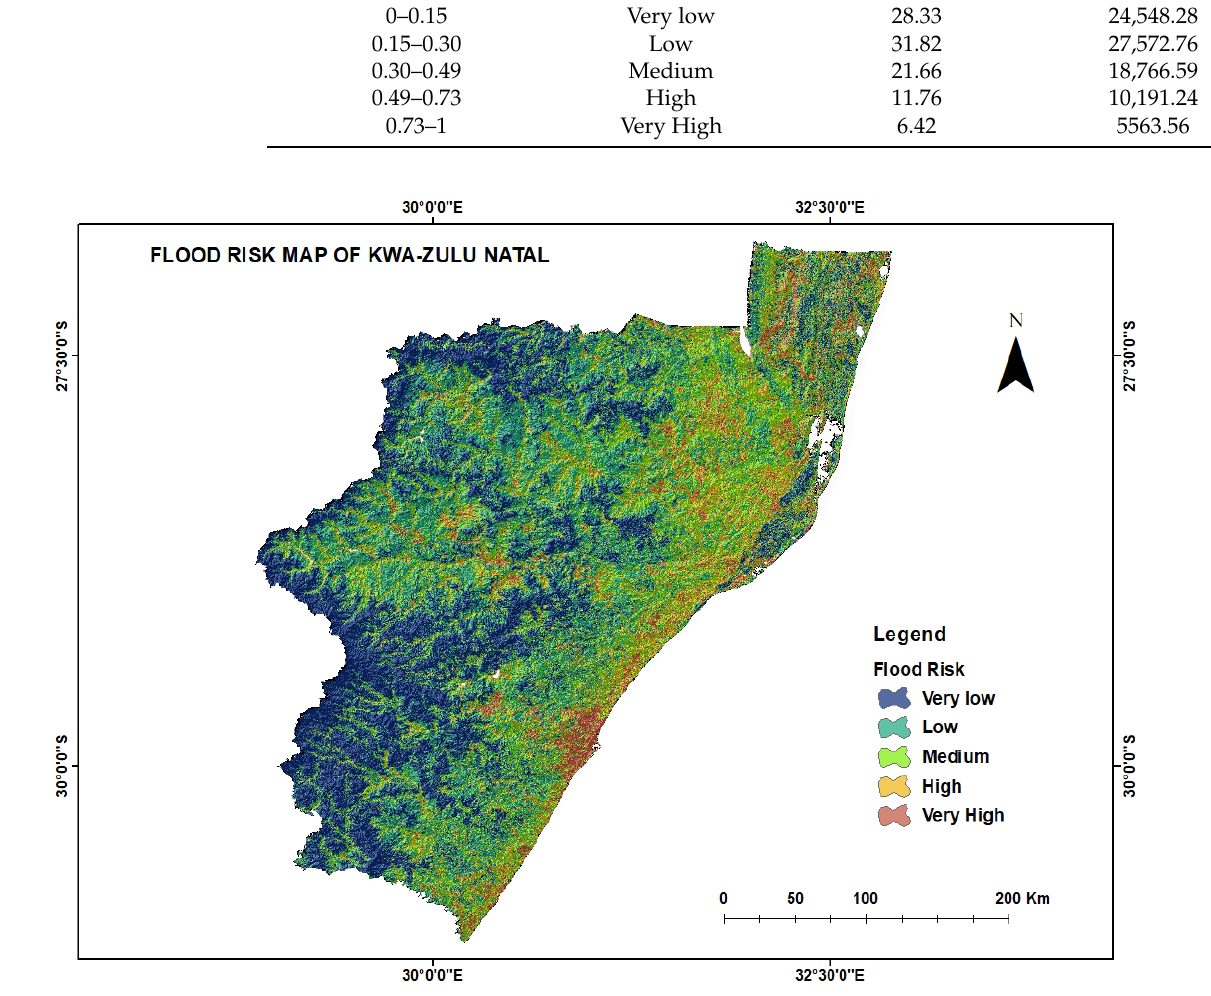
Figure 8. Flood risk map of KwaZulu-Natal, eastern South